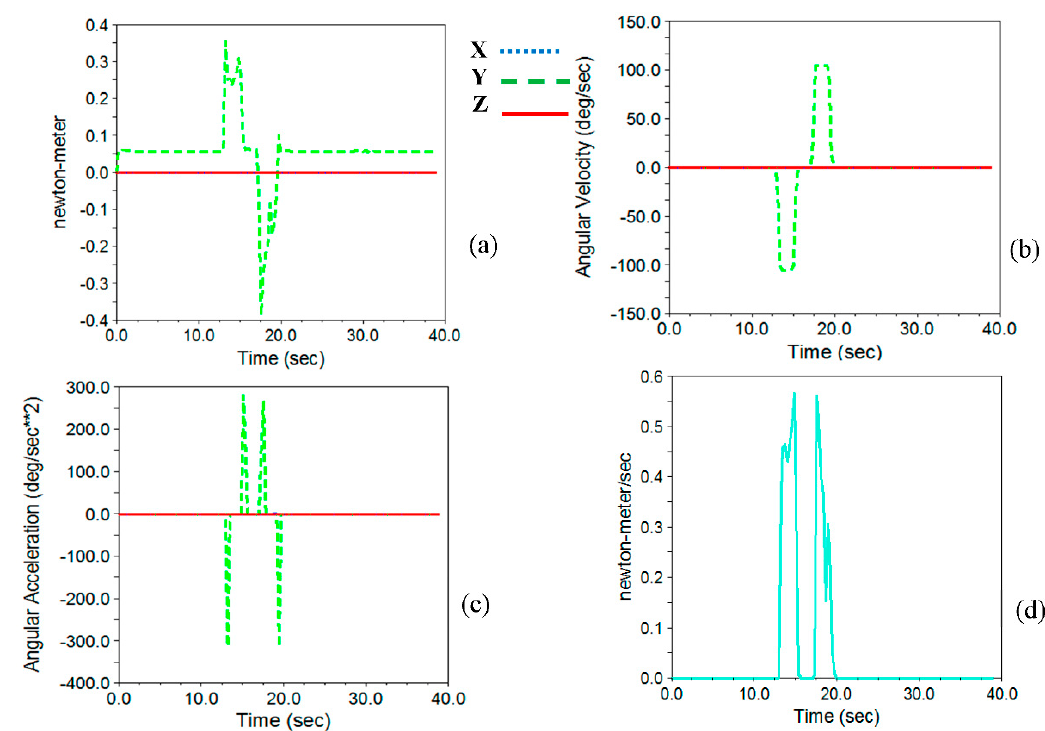
Figure 24. Results of ADAMS software simulation to determine the motor characteristics of the gutting subset (seven fish per minute). In this figure, ( a – d ) are torque, angular velocity, angular acceleration, and required power respectively.